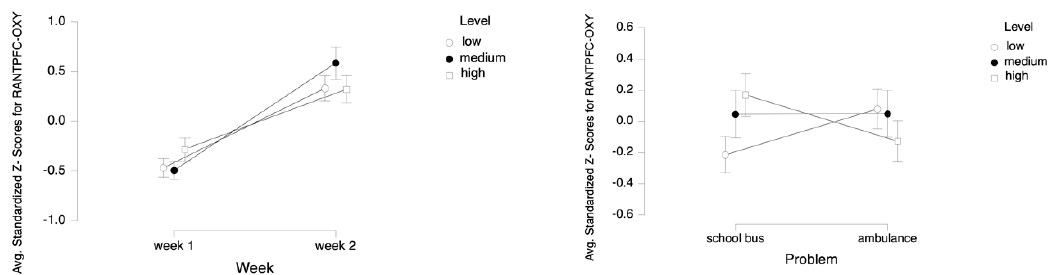
Figure 19. Line plots represent interaction effects of Level and Week (left) and Level and Problem (right) on average